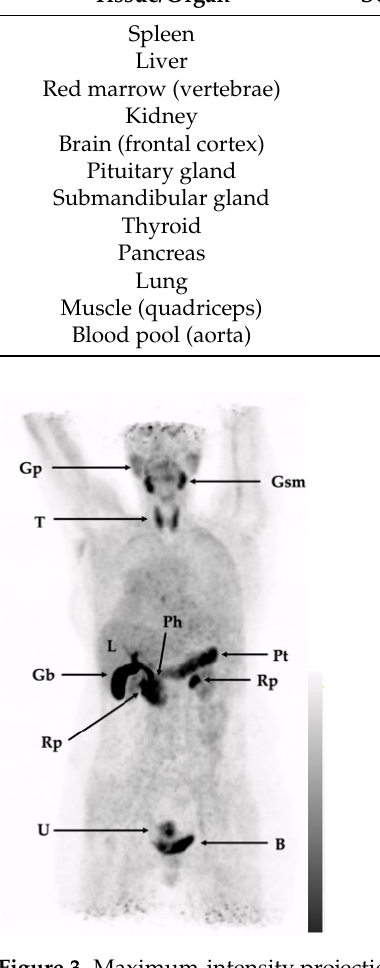
Figure 3. Maximum-intensity projection (MIP) of [ 68 Ga]Ga-DATA 5m .SA.FAPi in a patient without any disease-related tumor uptake. Gp: glandula parotis; Gsm: glandula submandibularis; T: thy- roid; L: liver; Ph: pancreas head; Pt: pancreas tail; Gb: gall bladder; Rp: renal pelvis; U: uterus; B: urinary bladder.